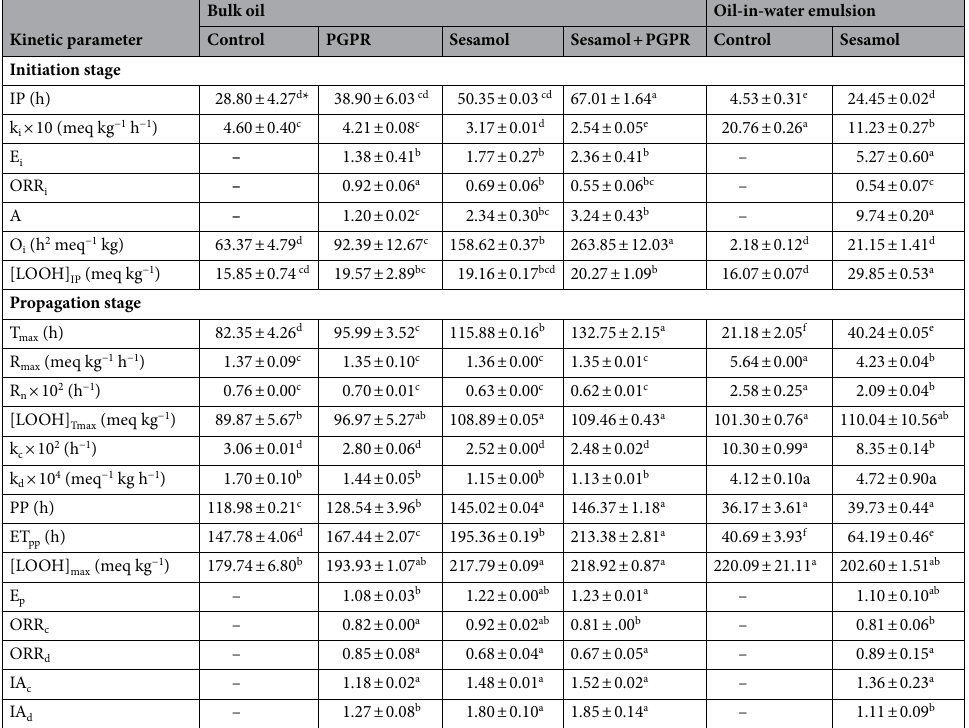
Table 1. Kinetic parameters of the initiation and propagation stages of sunflower oil oxidation. In each row, means with different superscript letters are significantly different ( P < 0.05). IP induction period, k i pseudo- zero order rate constant at the initiation stage, E i antioxidant effectiveness during the initiation stage, ORR i oxidation rate ratio during the initiation stage, A antioxidant activity, O i oxidizability index, [ LOOH ] IP lipid hydroperoxides concentration at IP point, T max occurrence time of maximum rate of lipid hydroperoxide formation at the propagation stage, R max maximum rate of lipid hydroperoxide formation in the propagation stage, R n normalized form of maximum rate of lipid hydroperoxides formation in the propagation stage, [ LOOH ] Tmax lipid hydroperoxides concentration at the point of T max , k c pseudo-first order rate constant of LOOHs formation at the propagation stage, k d pseudo-second order rate constant of LOOHs decomposition at the propagation stage, PP duration of the propagation stage, ET pp end time of the propagation stage, [ LOOH ] max maximum concentration of produced LOOHs, C integration constant, E p antioxidant effectiveness during the propagation stage, ORR c oxidation rate ratio of LOOHs formation during the propagation stage, ORR d oxidation rate ratio of LOOHs decomposition during the propagation stage, IA c inhibitory activity against the LOOHs formation, IA d inhibitory activity against the LOOHs decomposition. *Mean ± SD ( n =